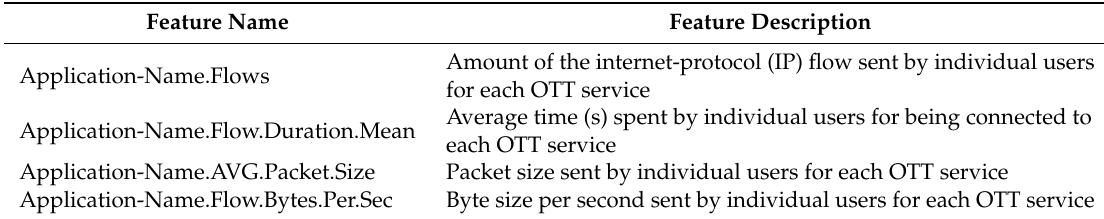
Table 1. Feature